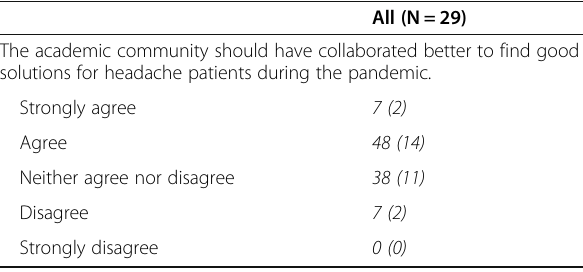
Table 2 Data on experience with the academic headache community during the pandemic (N = 29)